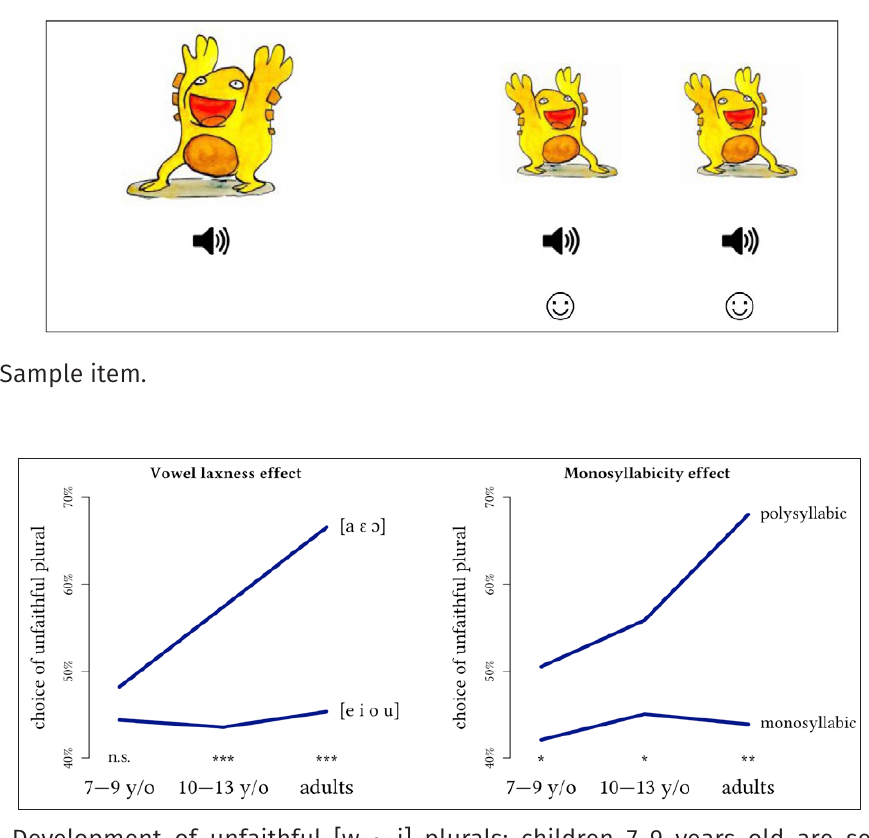
Figure 2: Development of unfaithful [w ~ j] plurals: children 7–9 years old are sensitive to monosyllabicity but not to vowel